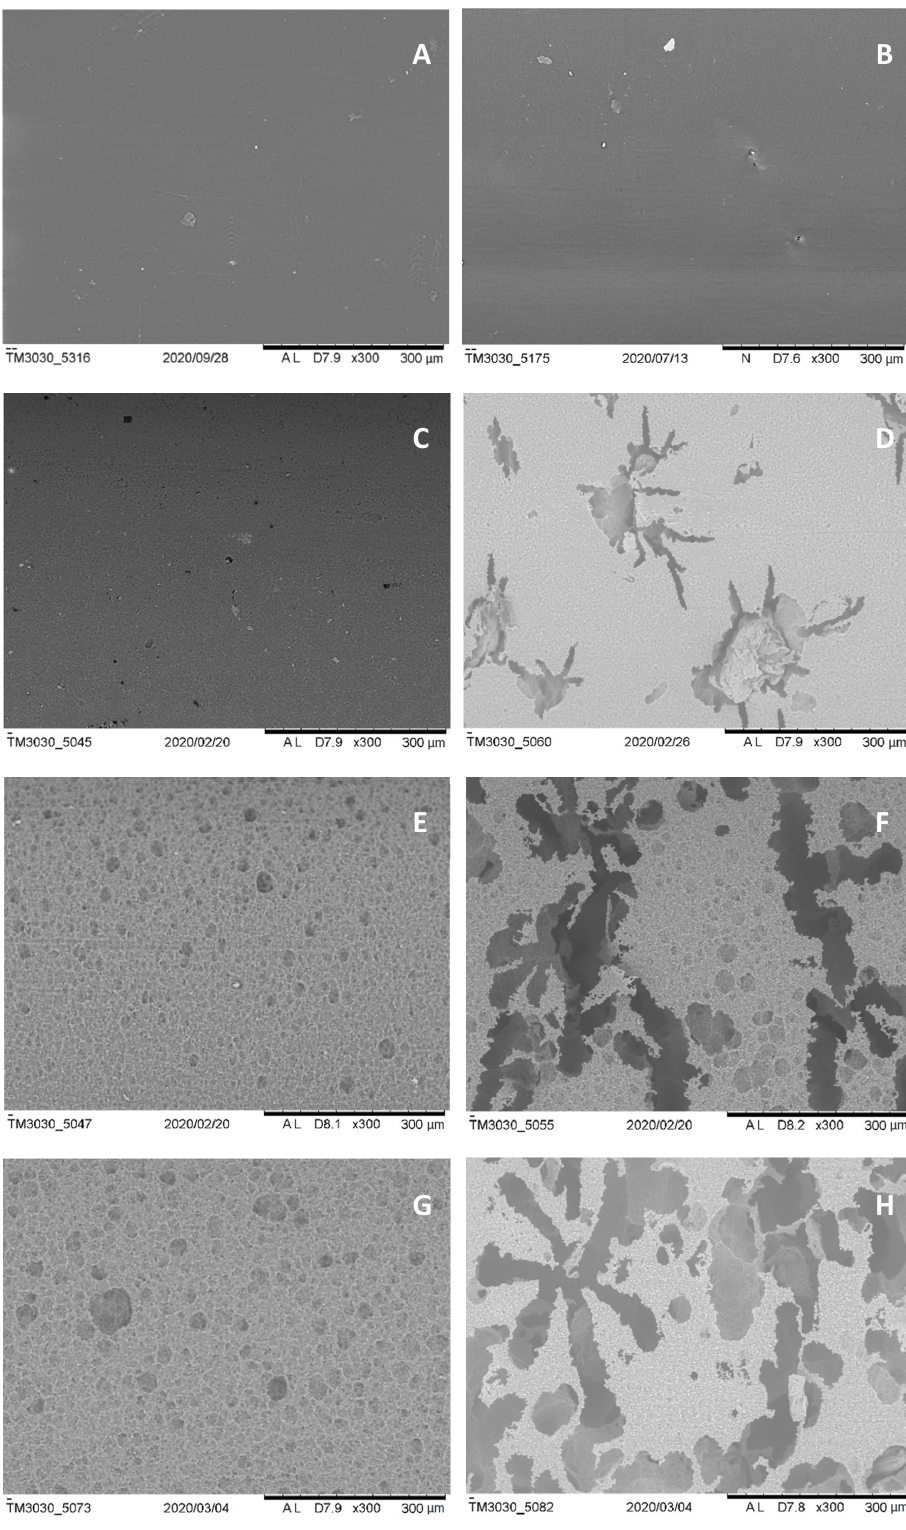
Figure 4. ( A ) PCL and ( B ) PCL:MCC 98:2 samples before enzymatic degradation; ( C ) PCL and ( D ) PCL:MCC 98:2 samples after 4 h of enzymatic degradation; ( E ) PCL and ( F ) PCL:MCC 98:2 samples after 24 h of enzymatic degradation; ( G ) PCL and ( H ) PCL:MCC 98:2 samples after 48 h of enzymatic degradation. Scale bar: 300 µ m. Magnification factor: ×